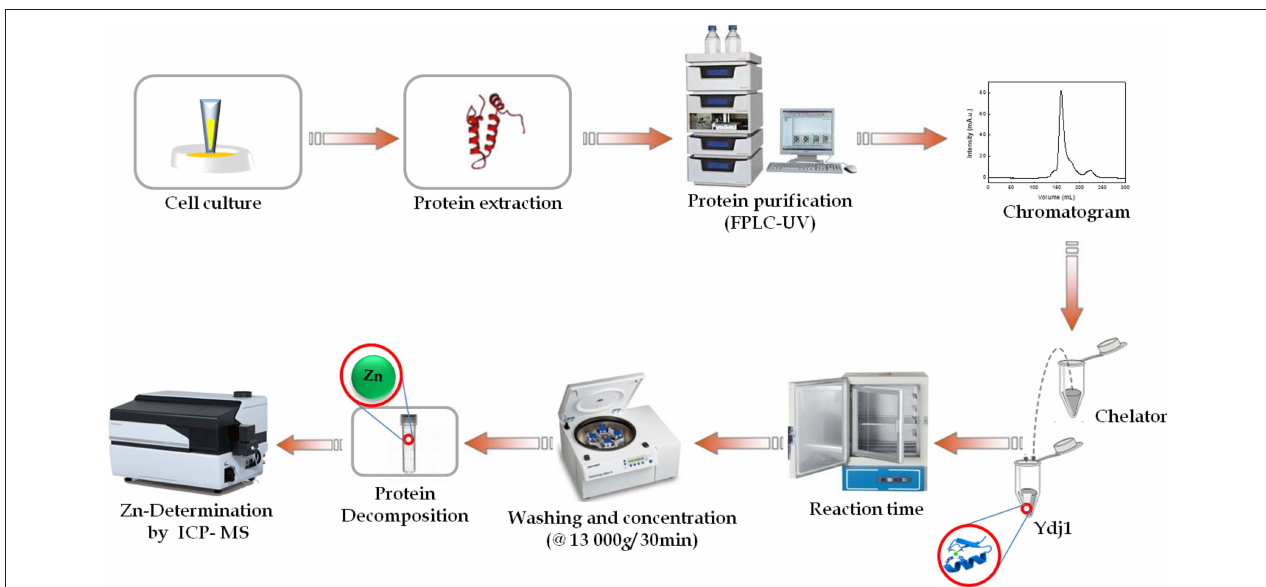
FIGURE 2 | Schematic flow of this work. General schematic of the expression and purification of Ydj1, as well as the zinc removal procedure. First, cell culturing was performed to express Ydj1. Then, Ydj1 was isolated free of contaminants using liquid chromatography. Then, an optimization methodology was performed to remove Zn from Ydj1. ICP-MS was used for Zn quantification analysis and to evaluate the efficiency of Zn removal.